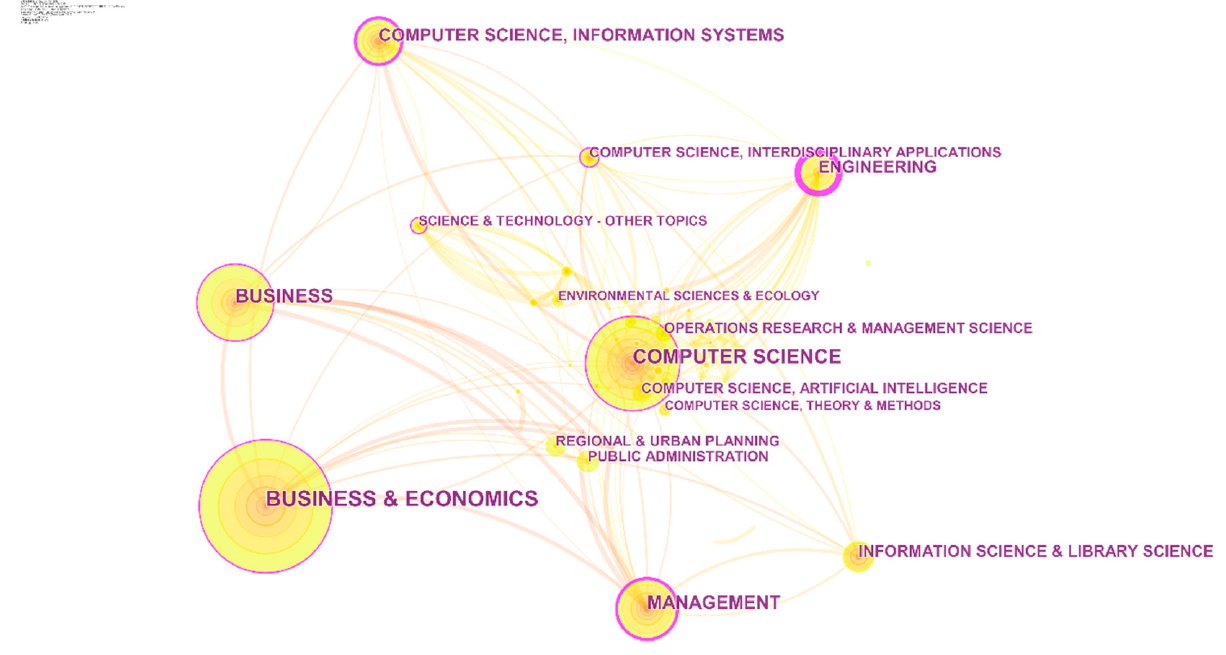
Figure 7. The distribution of categories (The circles represent categories involved). Table 6. Top 10 categories distribution.